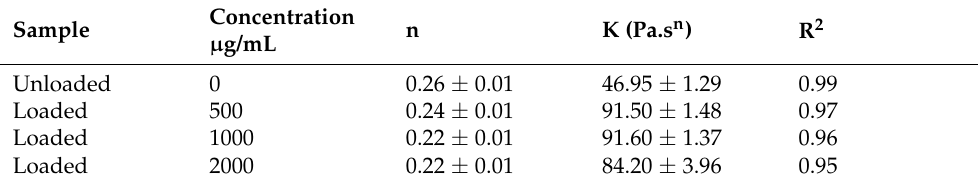
Table 4. Ostwald de Waale Parameters of Quercus resinosa extract in loaded and unloaded bigels. Sample